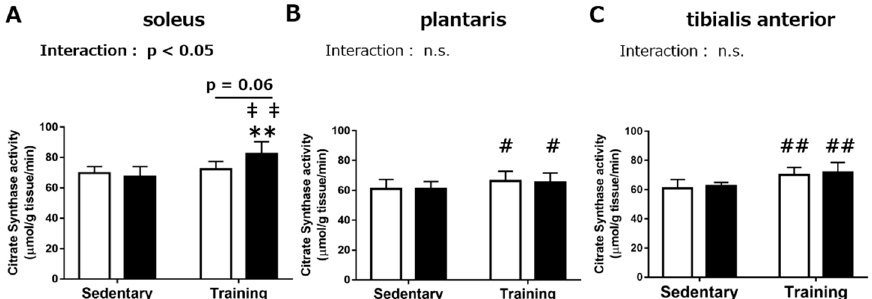
Figure 1. Maximal activity of citrate synthase in the soleus ( A ), plantaris ( B ), and tibialis anterior muscle ( C ) of the mice after treatment with royal jelly (RJ-treated group; black) or distilled water (Control group; white), with or without endurance training for three weeks (Chronic experiment). Values represent mean ± standard error. n = 6–8 per group. # p < 0.05 and ## p < 0.01, main effect of endurance training. ** p < 0.01, statistical significance vs the RJ-treated sedentary group. ‡‡ p < 0.01, statistical significance between the control sedentary group. n.s.: not significant.